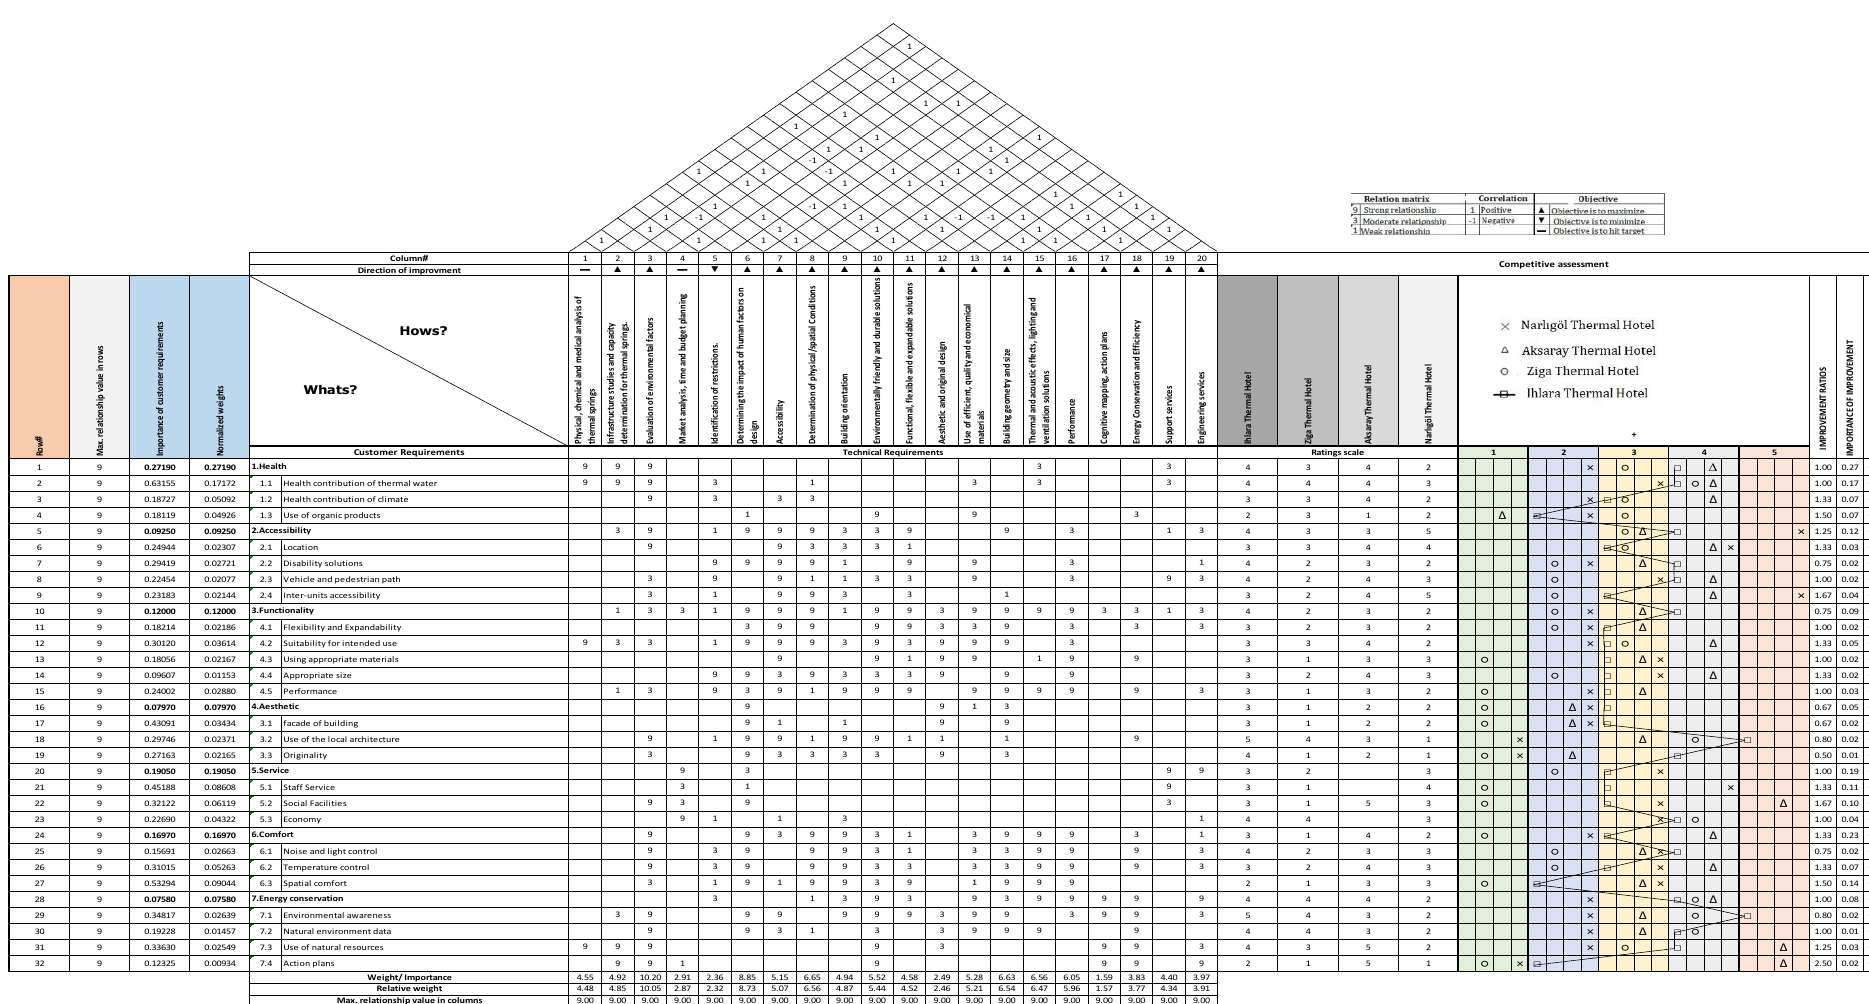
Figure 4. The house of quality for thermal hotel design.